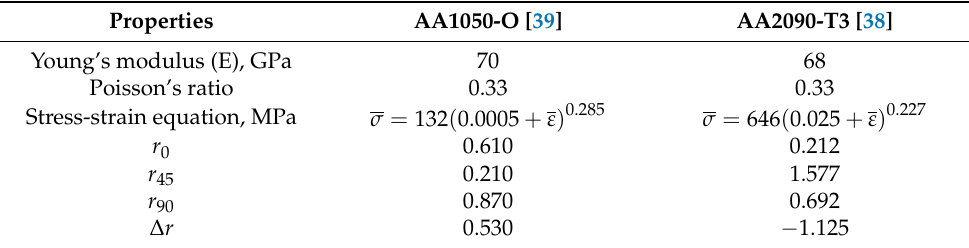
Table 2. Material properties of the blank sheets.